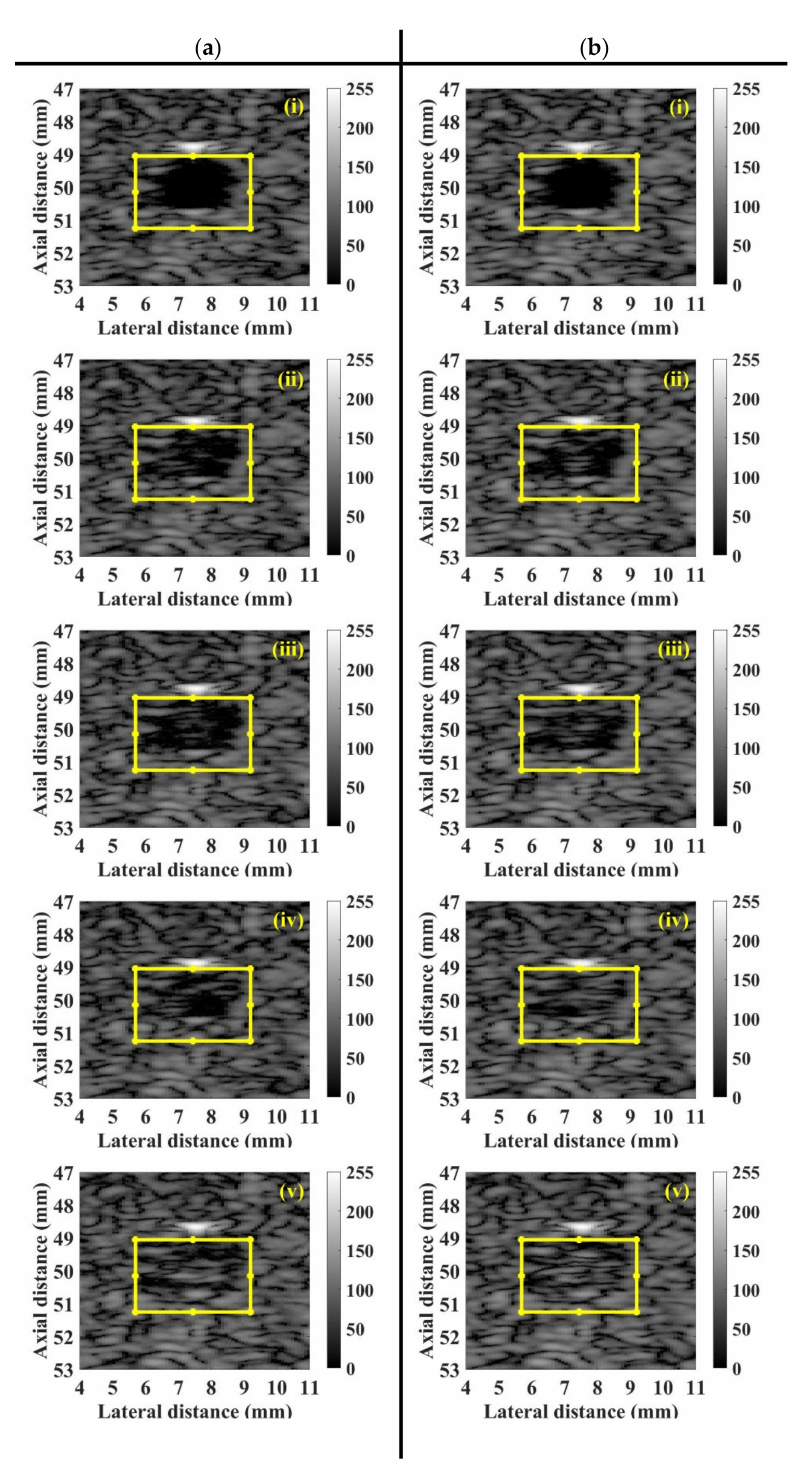
Figure 5. Typical B-mode images corresponding to the incidence of ( a ) 2.86 and ( b ) 4.37 MPa acoustic pressures into the flow phantom in which UCAs concentrations of (i) 0, (ii) 6.7, (iii) 13.3, (iv) 26.7, and (v) 53.3 × 106 UCAs / mL were